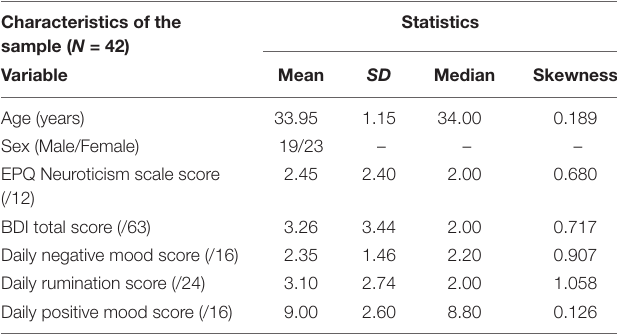
TABLE 1 | Characteristics of the